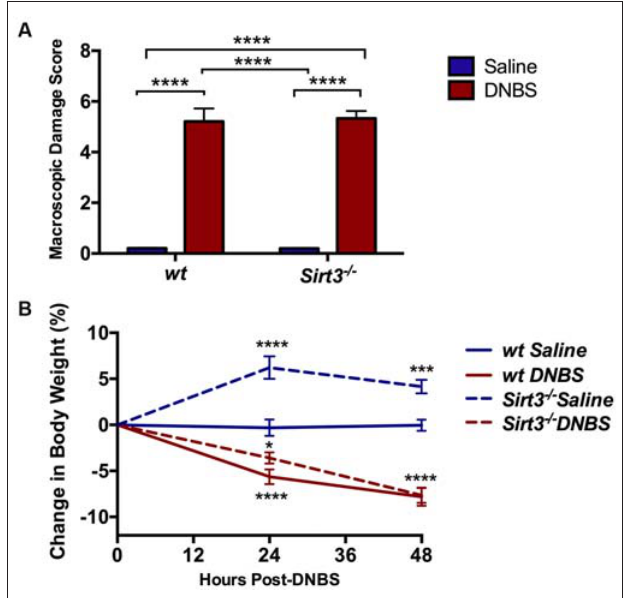
FIGURE 4 | Assessment of gross inflammation driven by dinitrobenzene sulfonic acid (DNBS)-colitis in wt or Sirt3 − / − mice as measured by macroscopic damage scoring (A) and monitoring changes in body weight (B; n = 5–7 per group, ∗ P < 0.05, ∗∗∗ P < 0.005, ∗∗∗∗ P < 0.001, 2-way ANOVA)